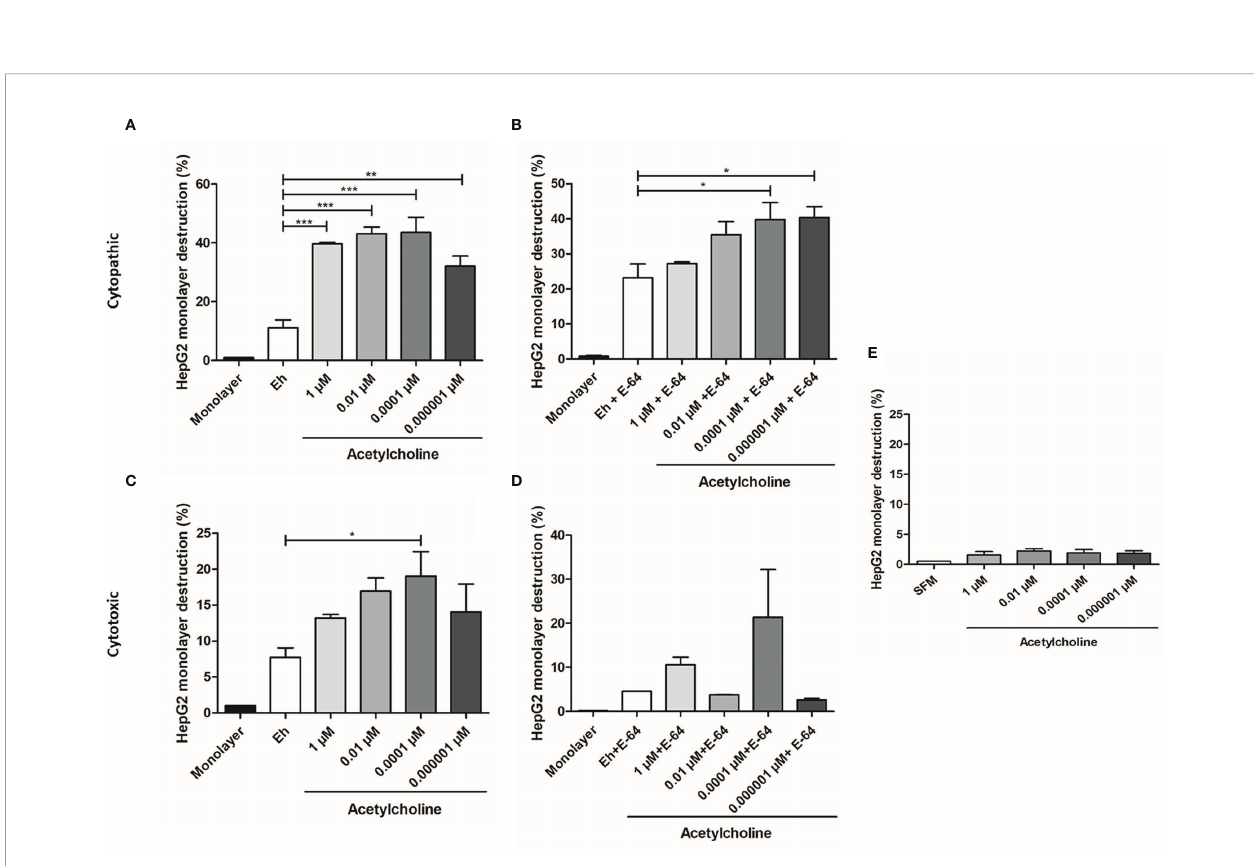
FIGURE 7 | Acetylcholine-mediated cytopathic and cytotoxic effects of E. histolytica trophozoites. (A) HepG2 cells in interaction with trophozoites pre-treated with different concentrations of ACh for 1 h. (B) HepG2 cells in interaction with trophozoites pre-treated with E-64 and different ACh concentrations for 1 h. (C) HepG2 cells incubated with supernatants of E. histolytica trophozoites previously stimulated with ACh for 1 h. (D) HepG2 cells incubated with supernatants of E. histolytica trophozoites pre-treated with ACh and E-64 for 1 h. (E) HepG2 monolayer treated with ACh for 2 h as a control. Data correspond to the mean ± SEM of three independent experiments (n = 3). The statistical analysis was performed with the Kruskal Wallis and Dunn posttest method, where the values of *p < 0.05, **p < 0.01 and ***p < 0.001 were considered signi fi cant.